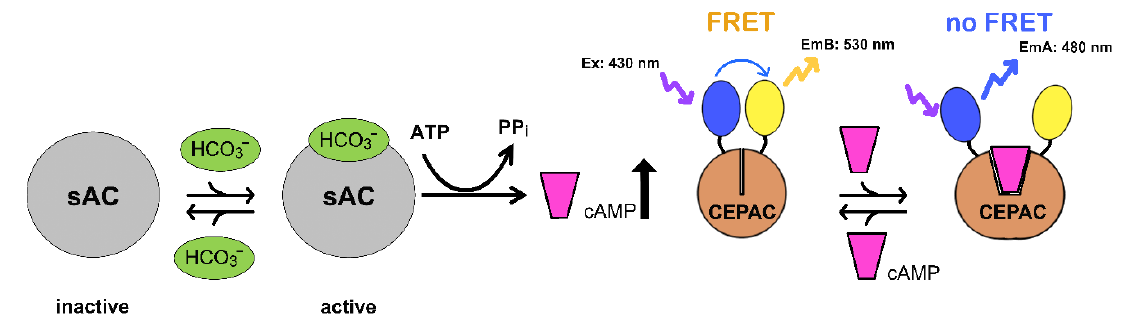
Figure 2. Bicarbonate sensory cellular test system. Upon induction via doxycycline withdrawal from the culture medium, the sAC-CEPAC cell line expresses the bicarbonate sensory cellular test system consisting of the catalytically active bicarbonate sensor soluble adenylate cyclase (sAC tr ) and the cAMP reporter CEPAC. When sAC tr is activated by bicarbonate (HCO 3 − ), the enzyme catalyzes cAMP synthesis and cAMP then binds to CEPAC. This results in a reduced energy transfer from the blue to the yellow fluorophore measured as a decrease in FRET intensity. When the bicarbonate sensory cellular test system is implemented in an enzymatically coupled bicarbonate assay, an increase in the fluorescence emission ratio due to a sAC tr -mediated increase in cAMP serves as a measure for the increase in intracellular bicarbonate concentration.